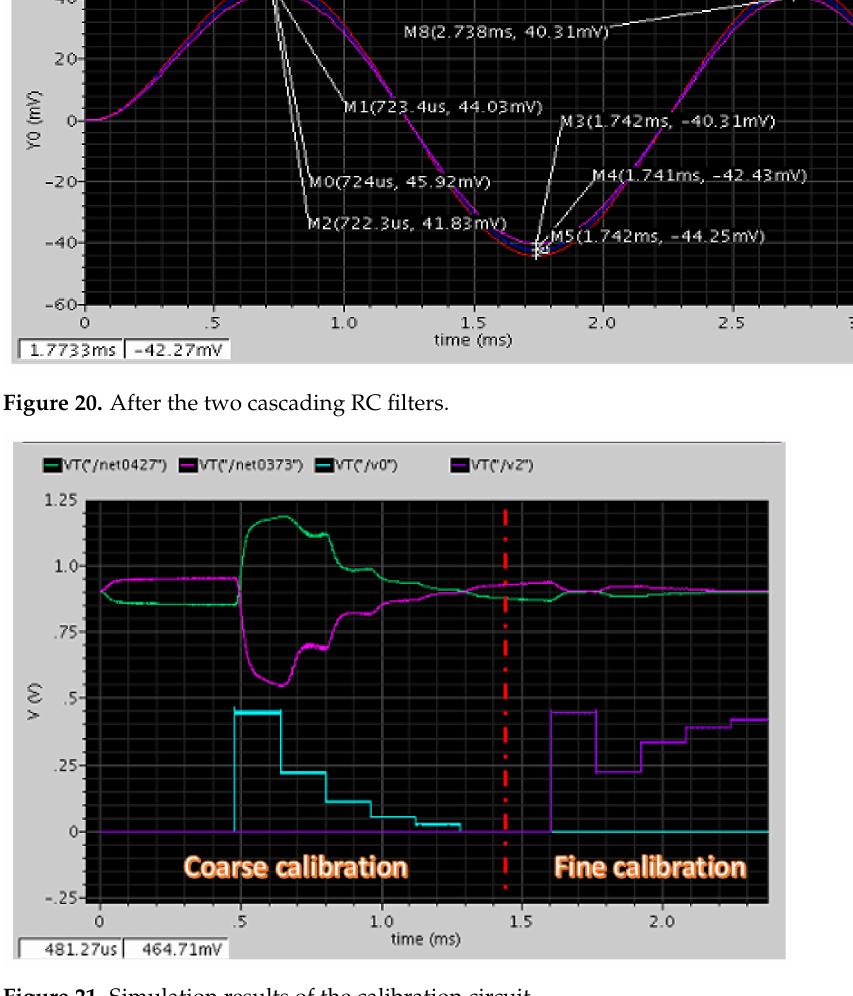
Figure 21. Simulation results of the calibration